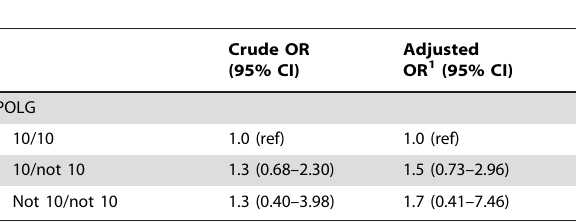
Table 2. Odd ratios of POLG-CAG repeat polymorphism in